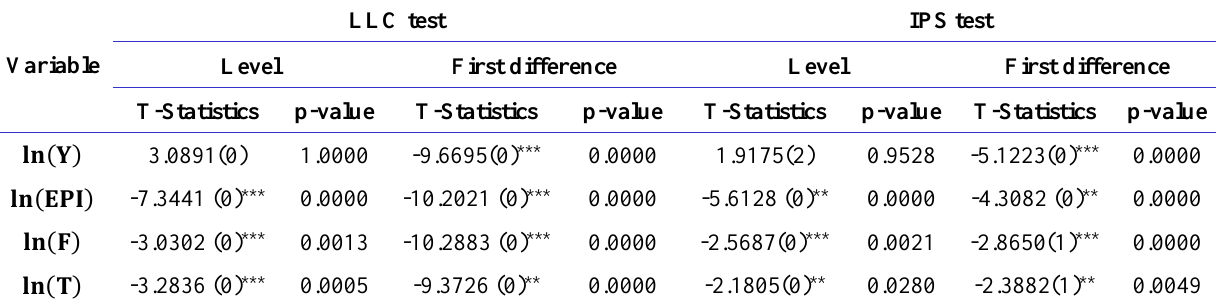
Table 2. Results of panel unit root